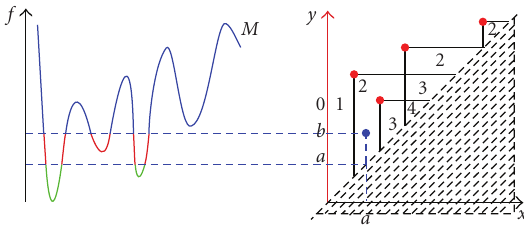
Figure 1: A curve and its Size Function.